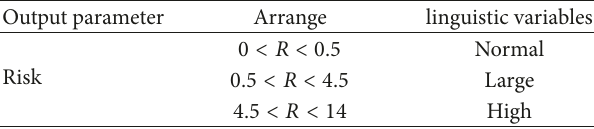
Table 5: The output variable (risk) ranges.